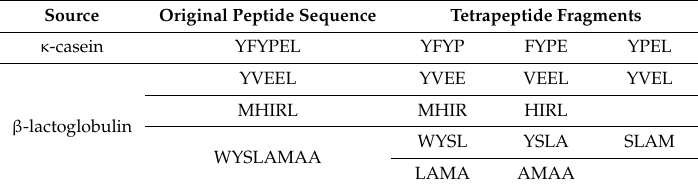
Table 1. Milk protein-derived peptides and their tetrapeptide fragments. Source Original Peptide Sequence Tetrapeptide Fragments κ -casein YFYPEL YFYP